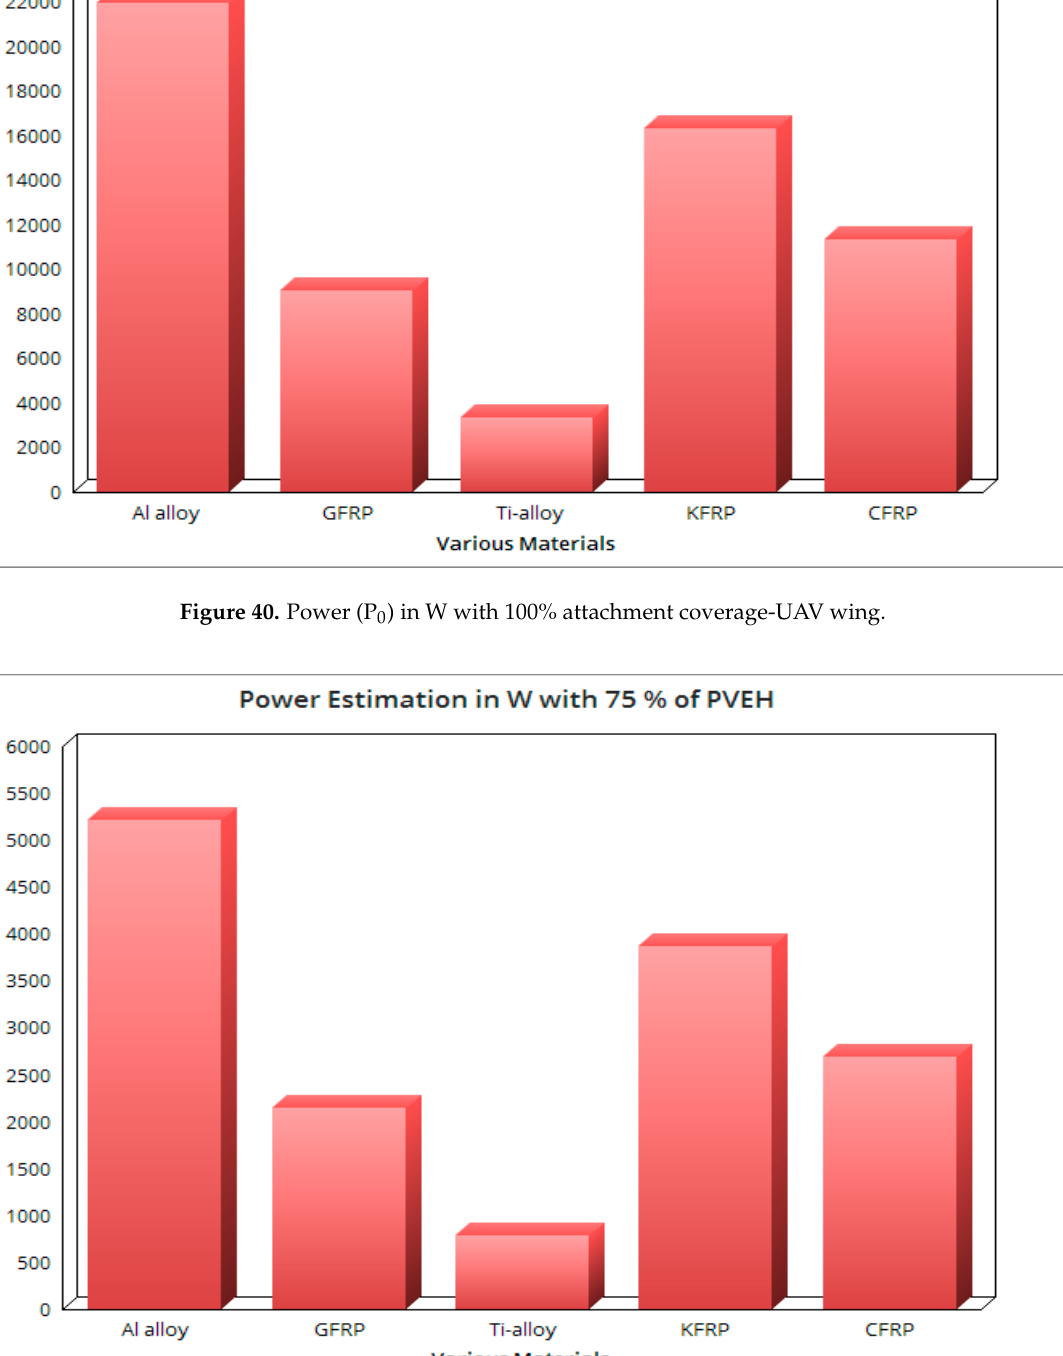
Figure 41. Power (P 0 ) in W with 75% attachment coverage-UAV wing.